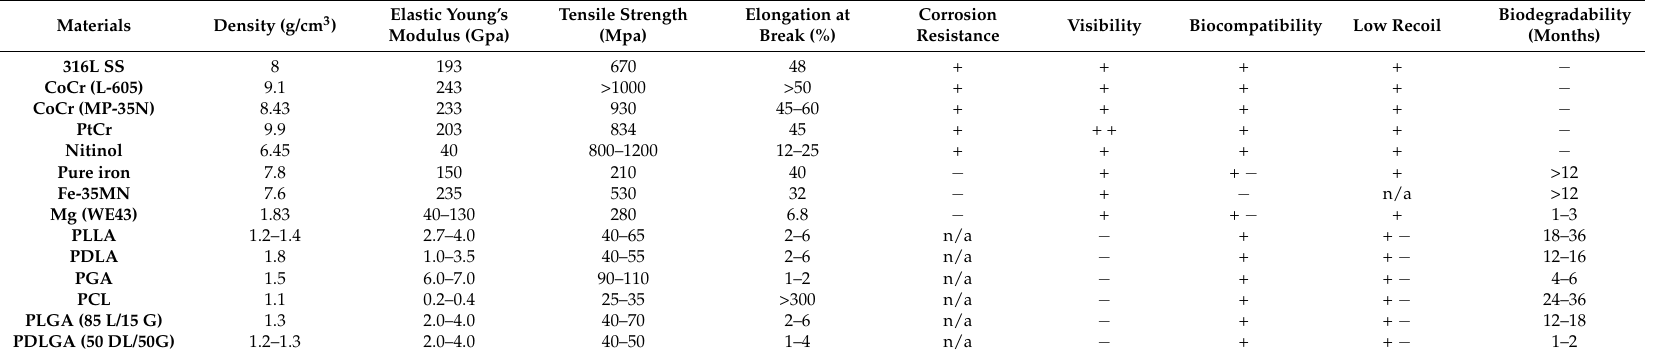
Table 2. Material properties for metallic alloys and common biodegradable